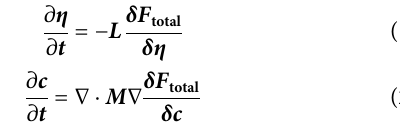
FIGURE2| Two-phasechemicalfreeenergydensitycurvesofzirconium matrix and zirconium hydride